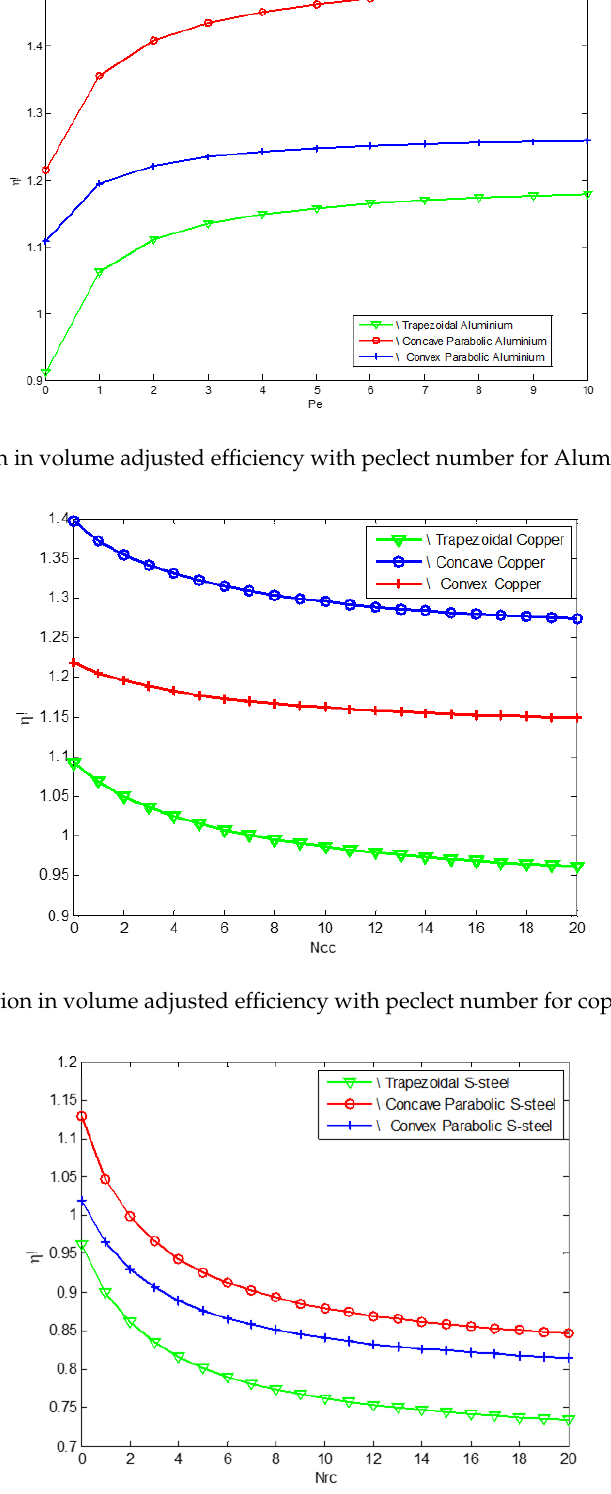
Figure 20. Variation in volume adjusted efficiency with peclect number for stainless steel porous